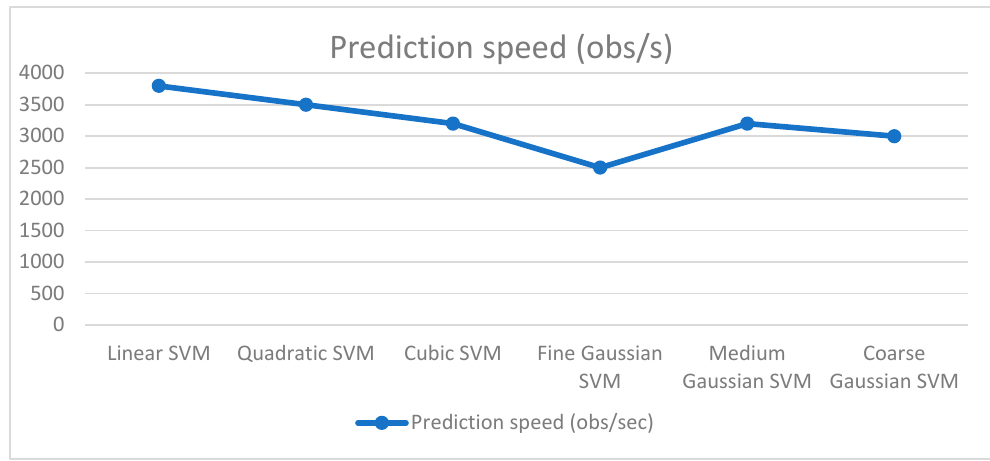
Figure 5. Demonstrated prediction speed of 250 features.